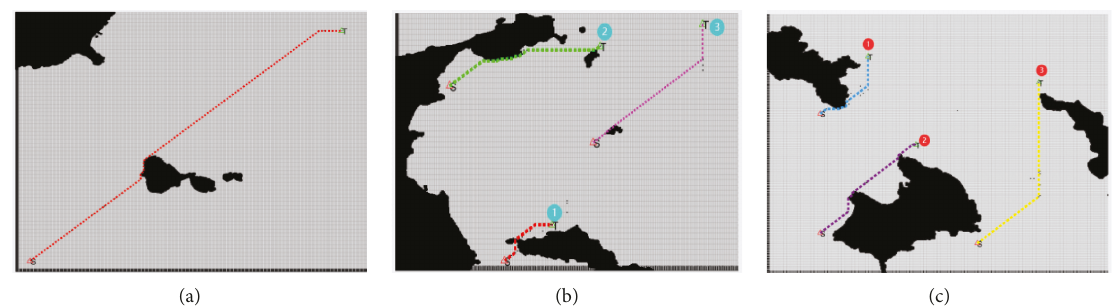
Figure 20: The path planning result of the algorithm in this paper. (a) Map_1. (b) Map_2. (c)